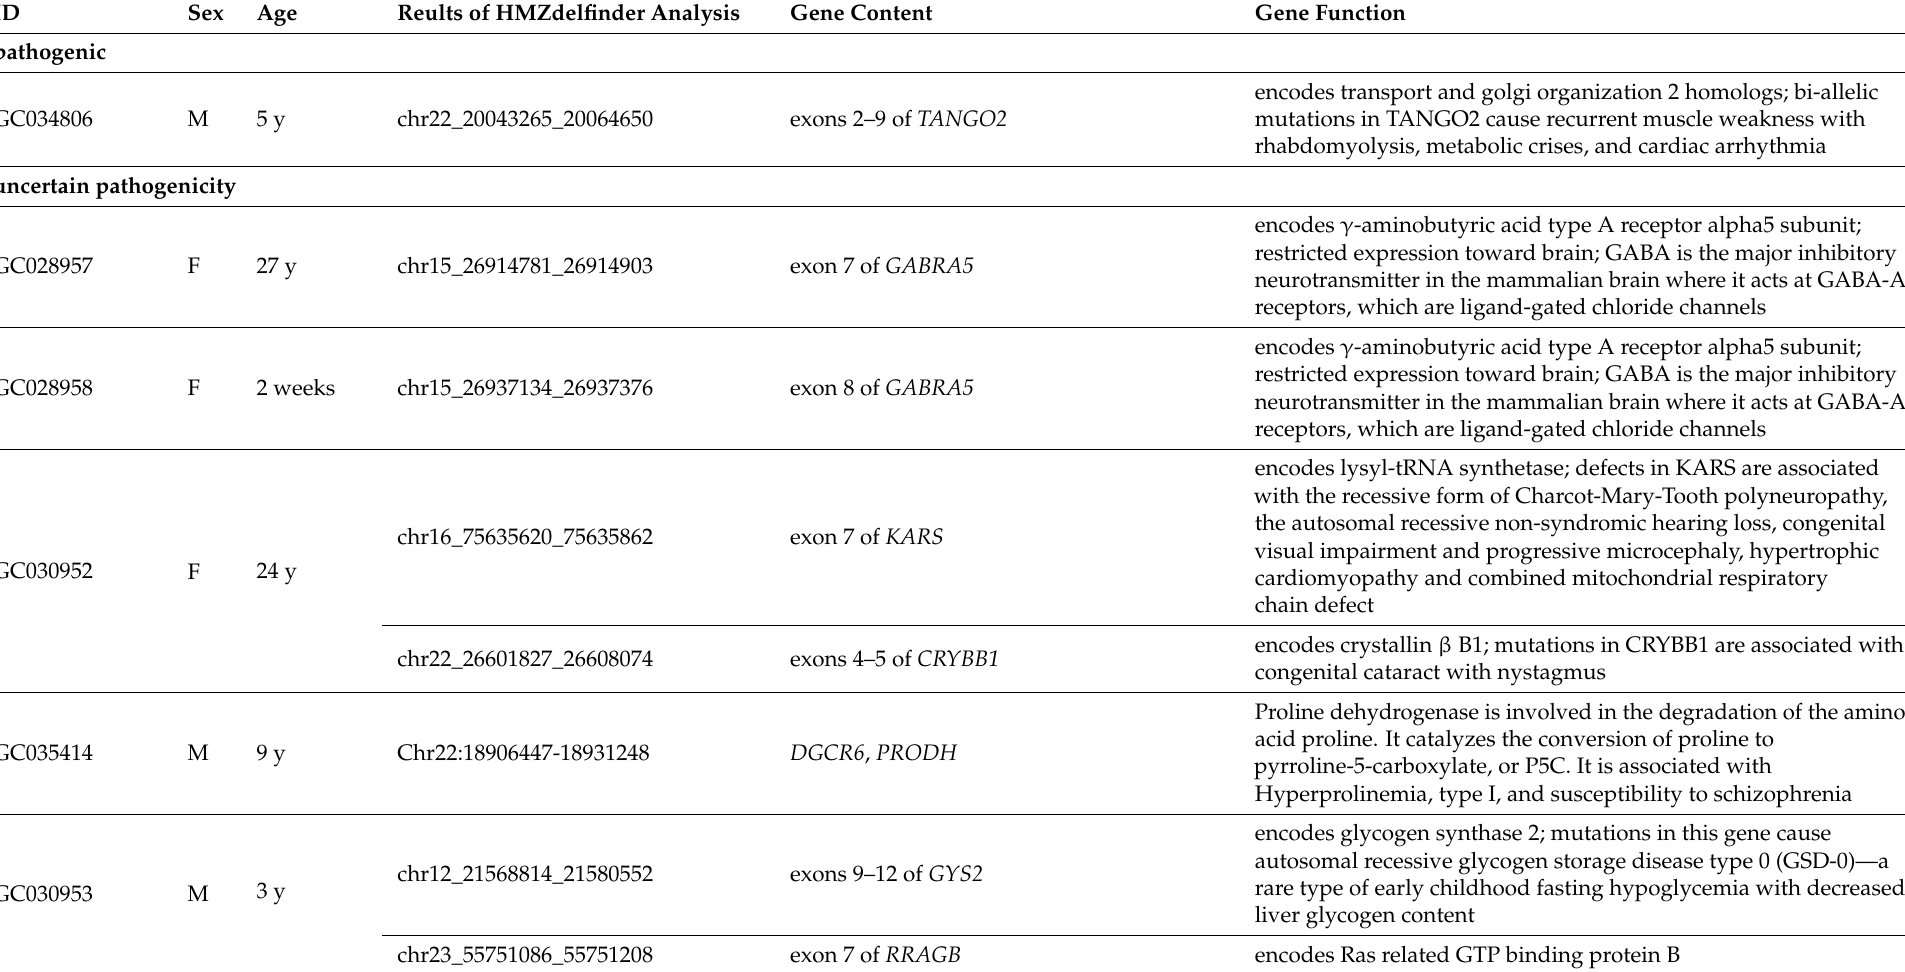
Table 4. Pathogenic and of uncertain clinical significance deletions identified by